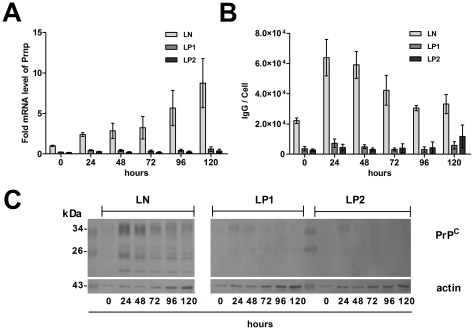
Expression of PrPC is stably repressed during the differentiation of MEL cells.(A) Level of PrP mRNA measured with qRT-PCR in cell lines stably expressing anti-Prnp shRNAmir (LP1 and LP2) is downregulated in comparison with control (LN) during the course of cell differentiation (2 experiments, mean ± SD). (B) The effect of silencing on the level of PrPC on cell membrane estimated by quantitative flow cytometry (four experiments, mean ± SD. (C) Confirmation of stable PrPC silencing on the protein level by western blot. PrPC was detected by mAb mix AH6, AG4 and 6H4. Actin was used as a loading control.